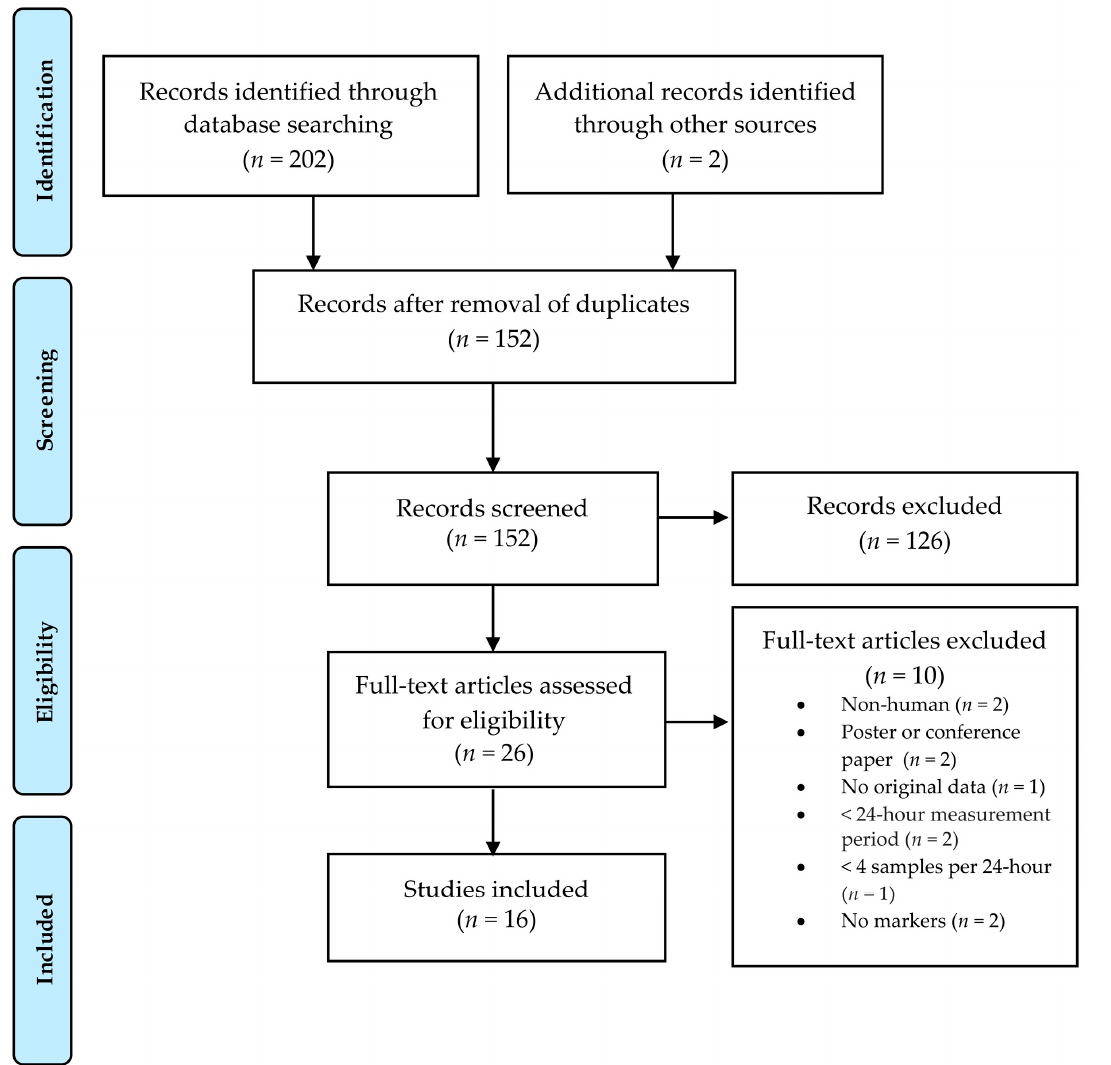
Figure 1. PRISMA flowchart of the study selection process.